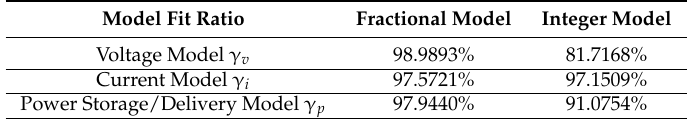
Table 1. Model fit ratios comparison between fractional models ( α = 0.1) and integer